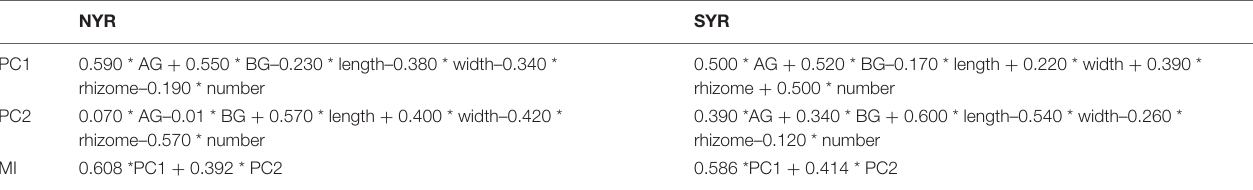
FIGURE 2 | Herbivory intensity of aboveground (S-above), belowground (S-below), and total parts (S-total) of seagrass among different herbivory treatments in the NYR (A) and SYR (B) (mean ± SE , n = 4). Within each parts of seagrass, bars sharing a letter are not significantly different from one another ( p > 0.05). TABLE 1 | Equations for the multi-metric index (MI) values of each site obtained from the eigenvectors of Supplementary Tables 1, 2